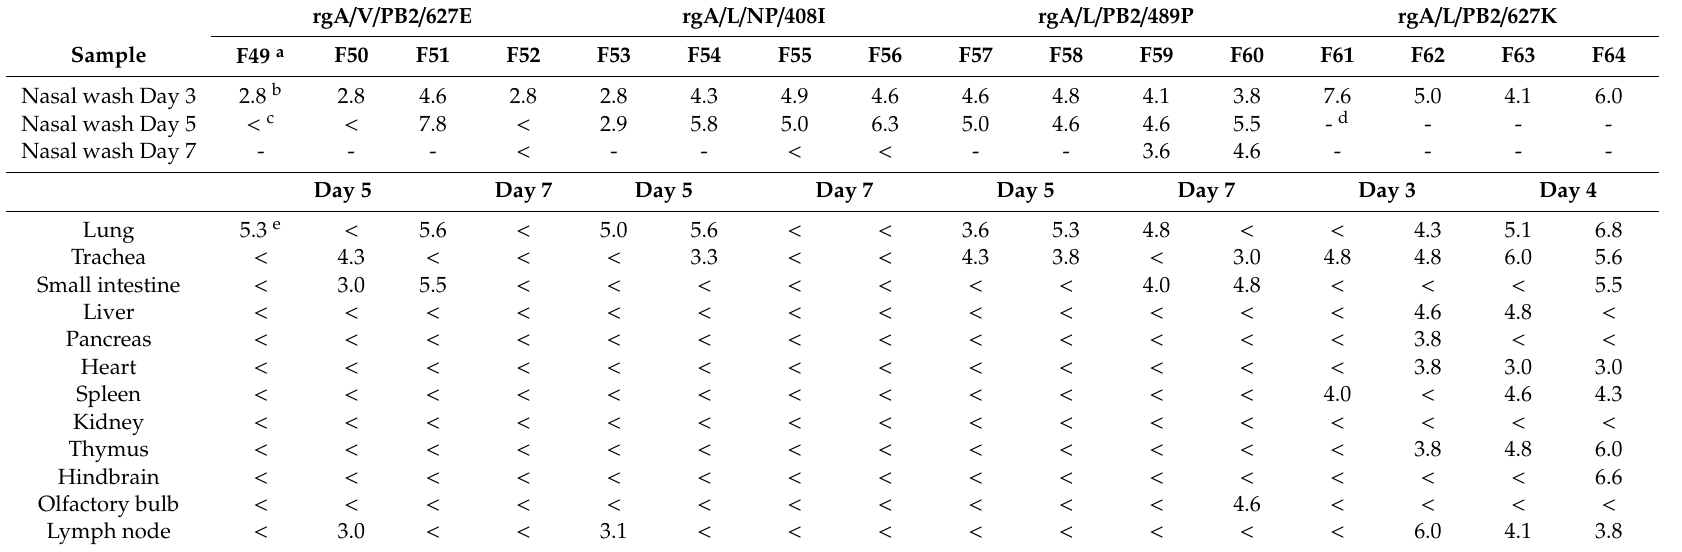
Table 8. Reverse-engineered viruses with mutations at either NP 408I or PB2 489P did not exhibit a high pathogenicity phenotype. rgA / V / PB2 / 627E rgA / L / NP / 408I rgA / L / PB2 / 489P rgA / L / PB2 /